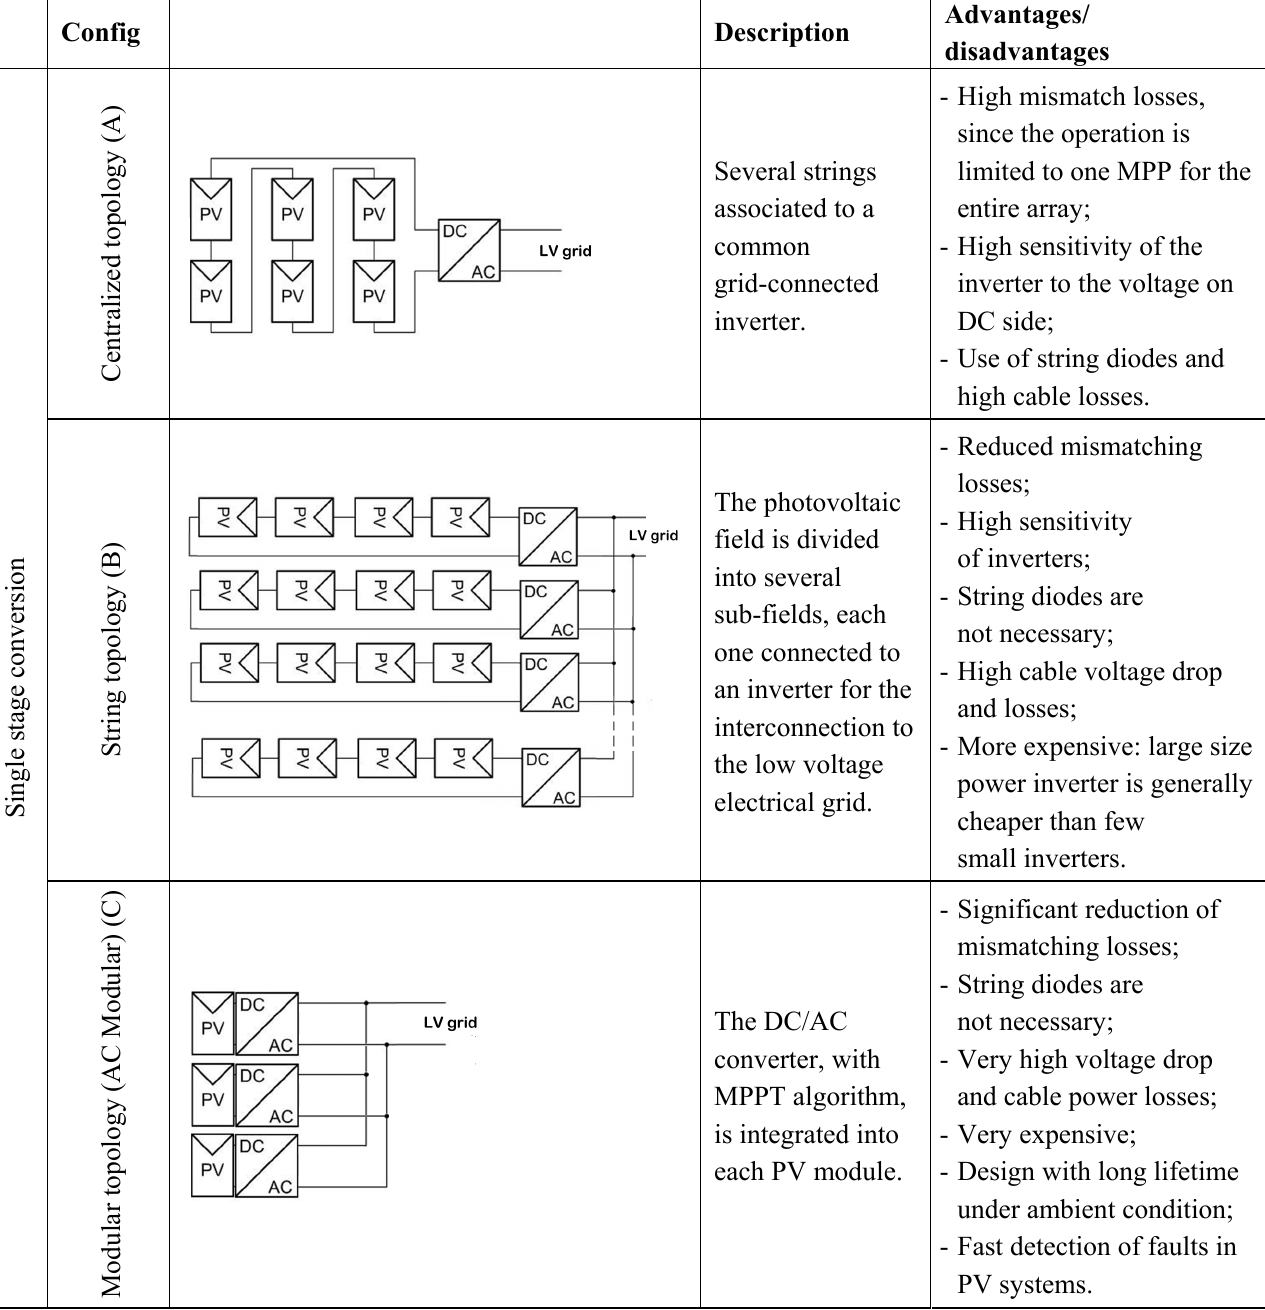
Table 1. Architectures of PV